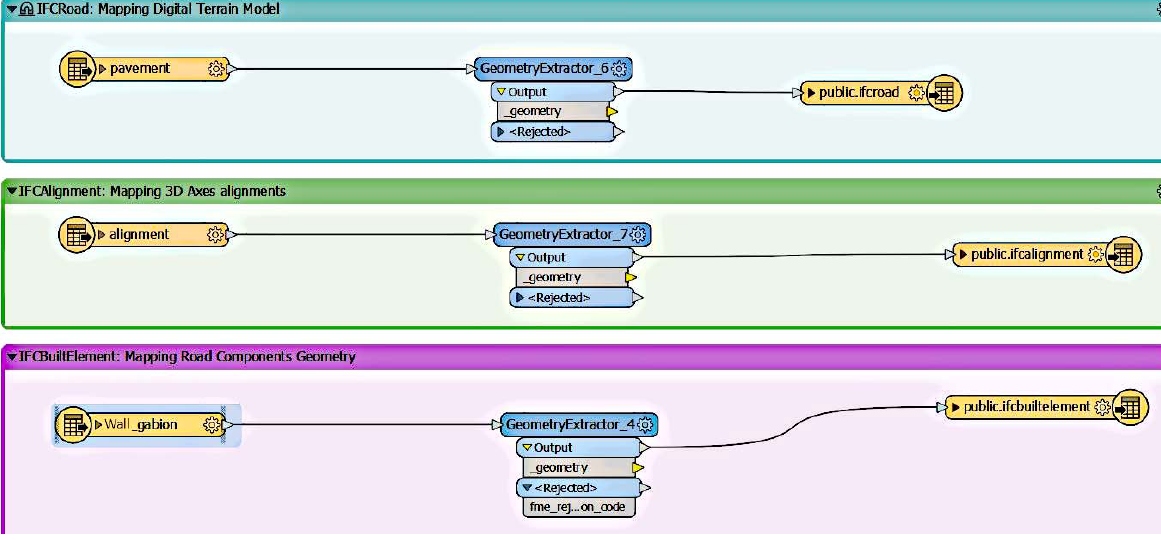
Figure 8. XML extract from the IFC model based on the IFC extension. An example of the three-dimensional visualisation of the road’s BIM objects is given in relation to the “IFCBuiltElement” represented by a dynamic barrier in Figure 9. This highway equipment is installed to retain rocks in case of a rock-fall event. Another example is illustrated in Figure 10. It displays an “IFCTask” operation of type and description designated as “Installation” and “installation of a gabion wall at the bottom